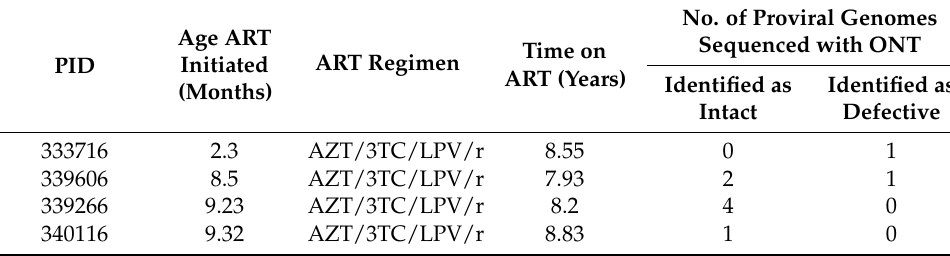
(Table 1). The participants were selected on the basis of having a total HIV-1 DNA count above 40 copies/10 6 PBMC [44,45]. At the time of testing, the participants had been on ART for 6–9 years. Furthermore, these participants were selected based on the probability of obtaining intact proviral genomes. Previously, Katusiime et al. identified seven intact NFL proviral genomes from three of the nine children using Illumina ® MiSeq™ sequencing [12]. These seven intact genomes were sequenced in the current study with ONT. In addition, two HIV genomes known to be defective were included in the analysis. The therapeutic histories and the respective number of proviral genomes in the participants selected for ONT sequencing are shown below. Table 1. Study participant details, treatment histories and identified proviral genome status.